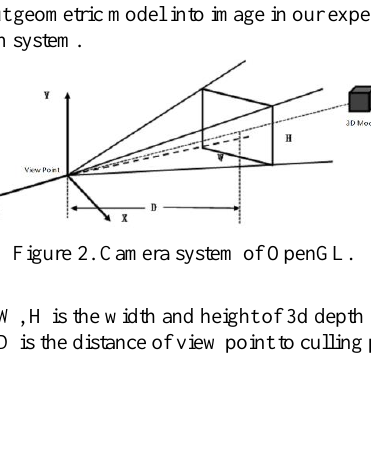
exclusive-or to the two result images and get result (right) as the seed area for target detection.